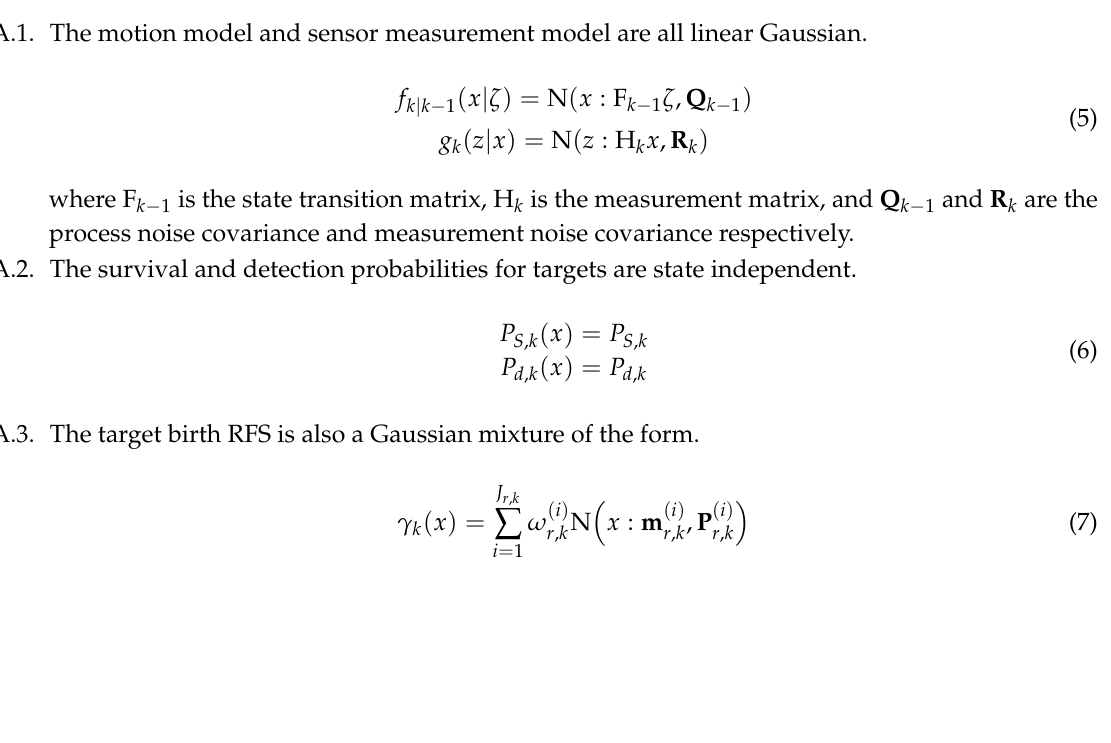
Figure 2. Relationship between Probability Hypothesis Density (PHD) and Gaussian Mixture Probability Hypothesis Density (GM ‐ PHD).